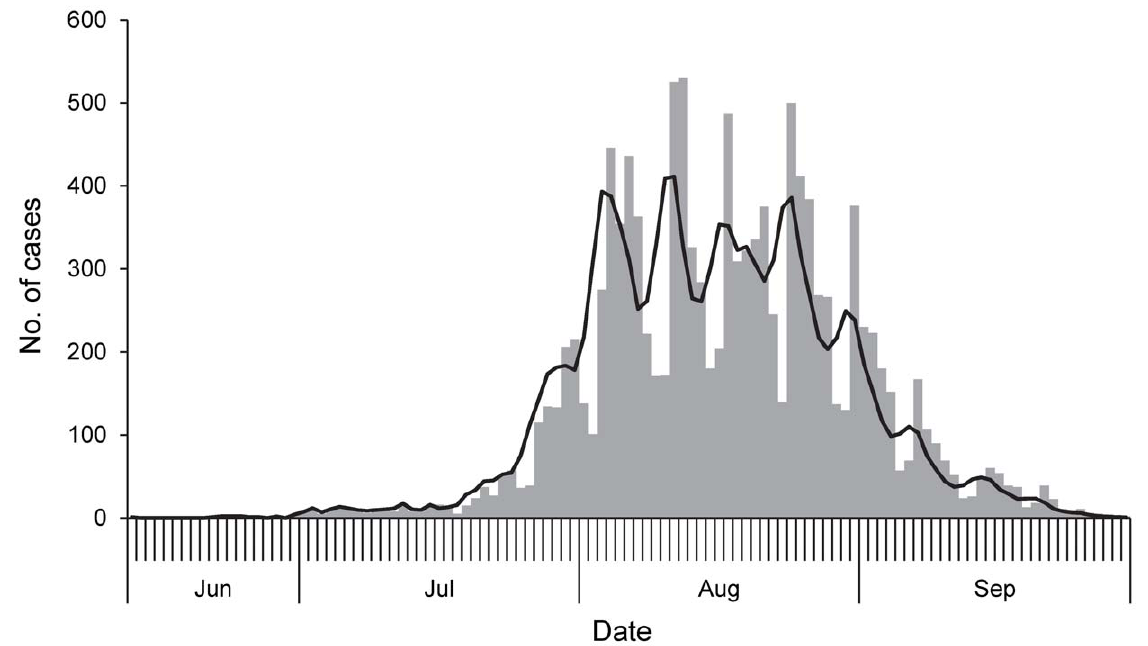
Figure 1. Epidemic curve of laboratory-confirmed influenza A(H1N1)pdm09 cases, South Africa, June 12 to September 30, 2009. Bars show original recorded data applying date of symptom onset where available (n=758) and substitute by date of specimen collection where onset was unavailable (total n=12,526). The line shows imputed data where date of symptom onset for missing case-based data was obtained by multiple imputations adjusted by provincial location of specimen collection and the occurrence of a case on a weekend day (n=12,491).